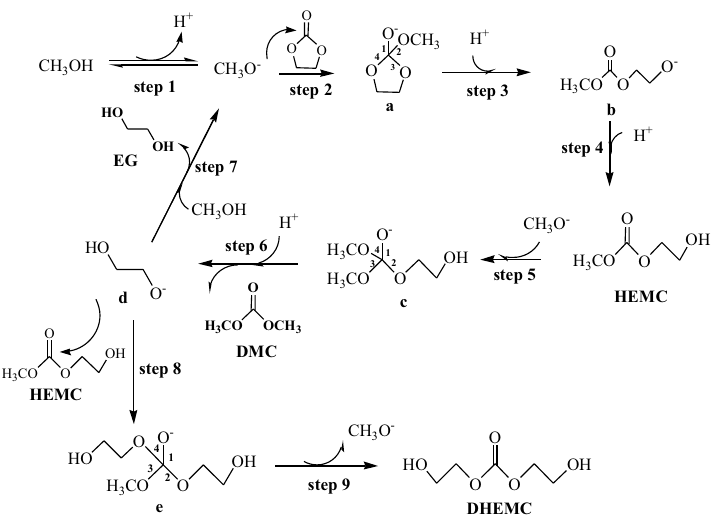
Figure 11. The proposed reaction mechanism of DMC synthesis via the transesterification of EC and methanol.